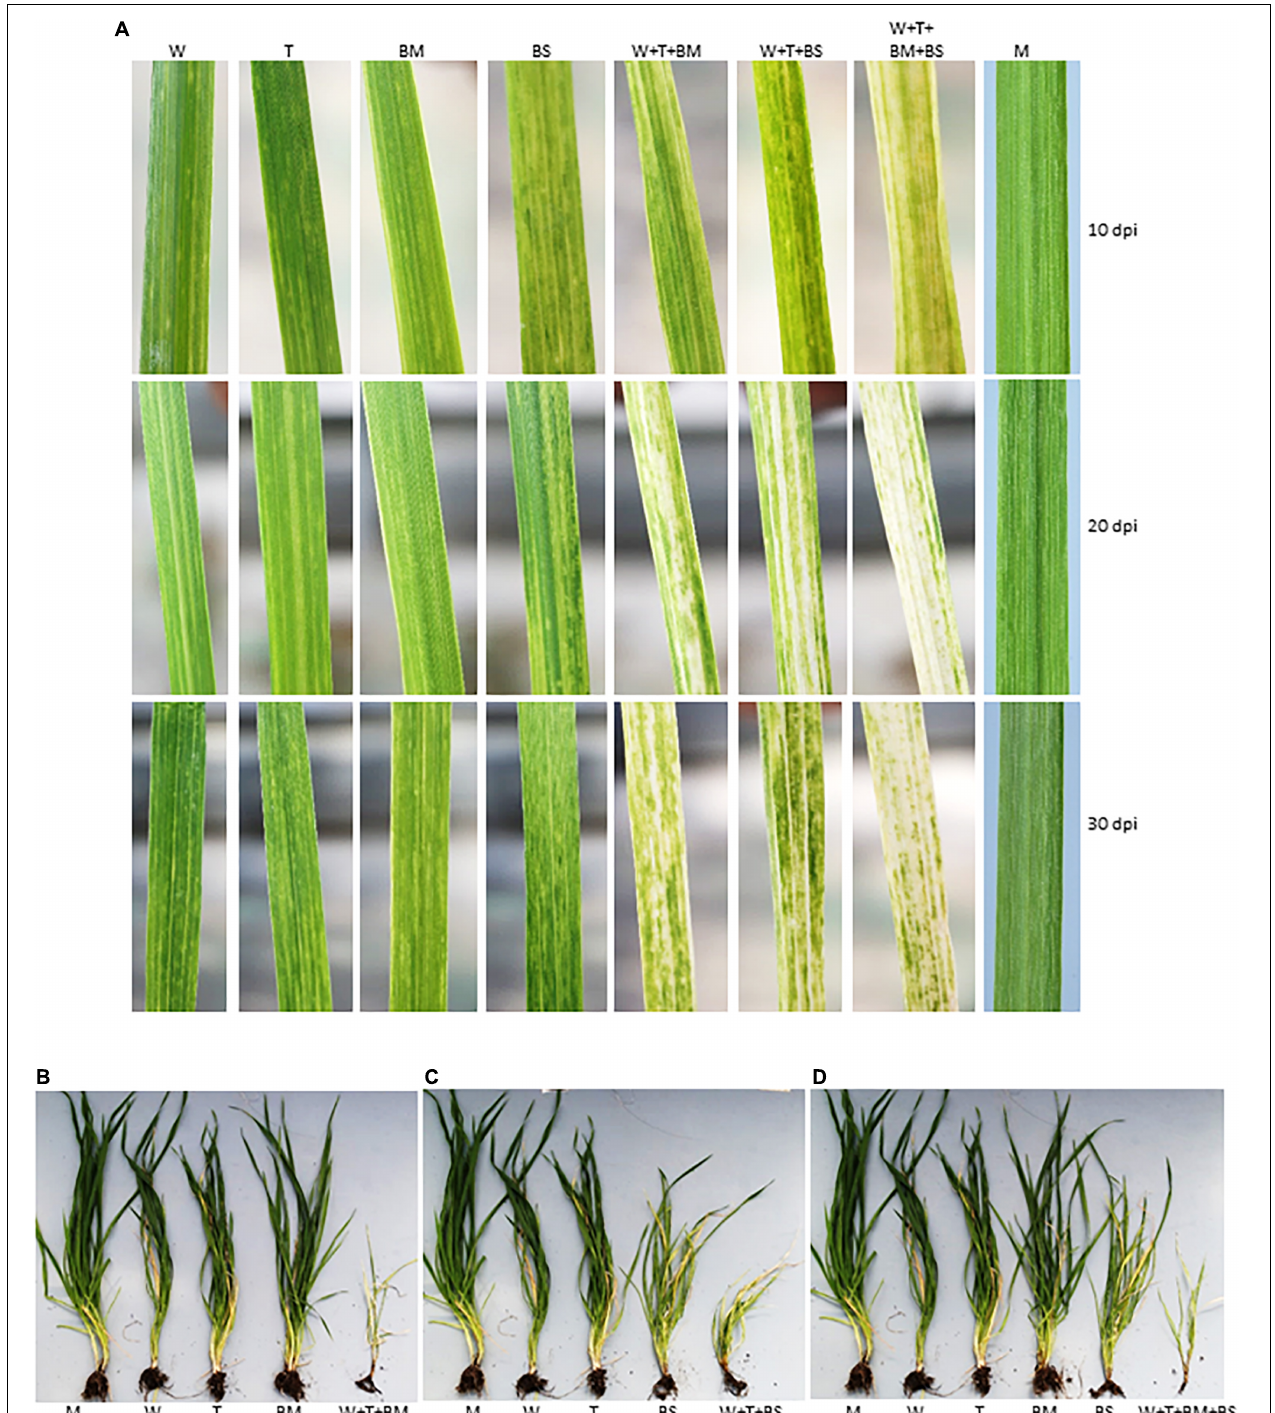
FIGURE 4 | Tri- and tetrapartite synergistic interactions among WSMV, TriMV, BMV, and BSMV in wheat cv. Arapahoe. (A) Wheat leaves showing the symptom phenotype of individual and co-infections by WSMV, TriMV, and BMV or BSMV or both on wheat at 10, 20, and 30 dpi. Note that co-infection of wheat by BMV or BSMV with WSMV and TriMV elicited more severe symptoms compared to individual virus infections. Co-infection of wheat by all four viruses induced severe chlorosis and bleaching of leaves. (B–D) Effect of co-infection of wheat by triple [WSMV + TriMV + BMV (B) and WSMV + TriMV + BSMV (C) ] or quadruple (D) viruses on wheat phenotype compared to singly infected plants. Wheat seedlings at the single leaf stage were inoculated singly or with a combination of viruses, and wheat plants at 30 dpi were uprooted and photographed. M, mock inoculation; W, WSMV; T, TriMV; BM, BMV; BS, BSMV.